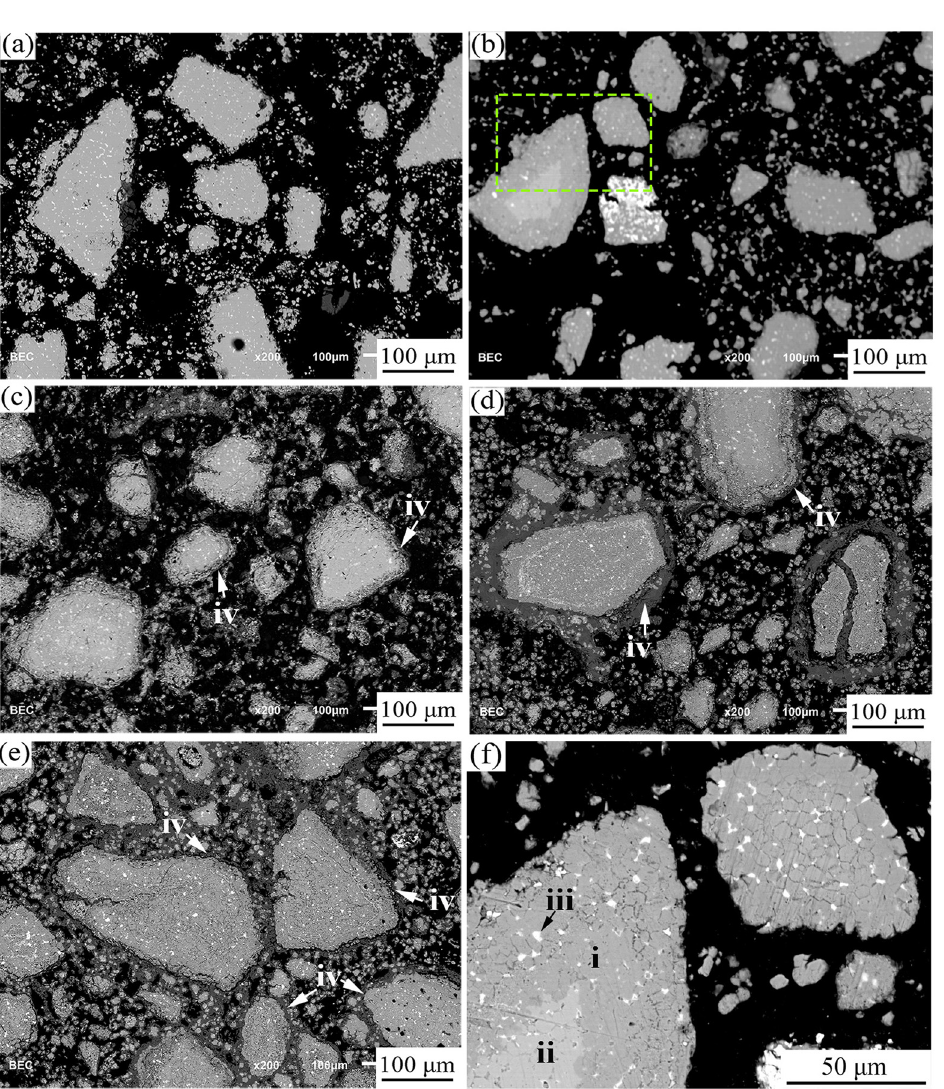
Figure 4: BSE images of the microstructure of the Nd – Fe – B magnet scrap powder roasted at 800°C with di ff erent roasting times. ( a ) The unroasted Nd – Fe – B scrap powder; ( b ) fi rst cycle of roasting; ( c ) second cycle of roasting; ( d ) third cycle of roasting; ( e ) fourth cycle of roasting; ( f ) enlarged view of the dashed box in ( b )